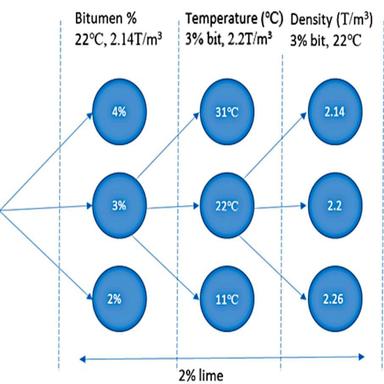
Summary of experiments used to develop the integrated fatigue model.